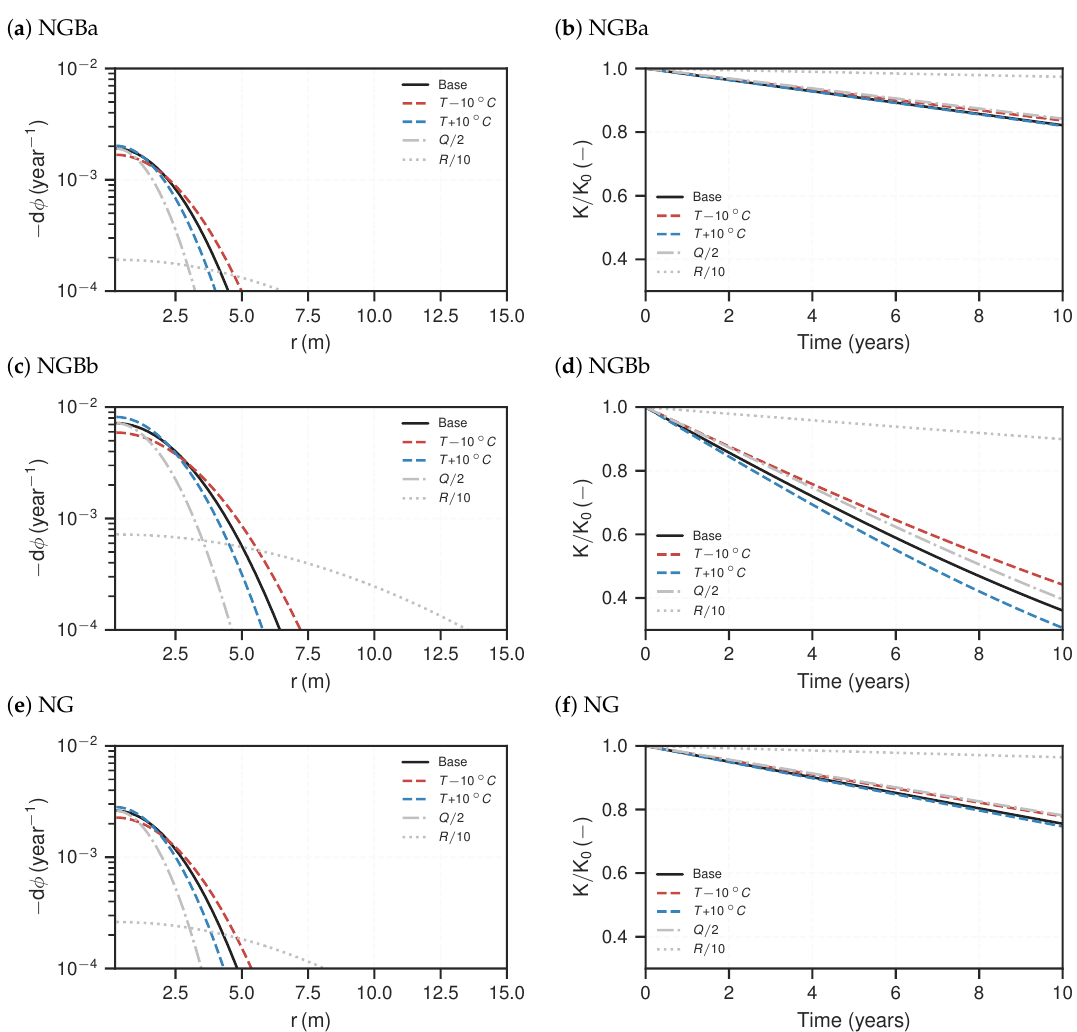
Figure 6. Reactive transport simulation results for the NGB cases. ( a , c , e ) Distribution of porosity change per year for steady-state. ( b , d , f ) Resulting relative, effective permeability loss (Equation (14)) based on the porosity–permeability relationship (Equation (13)) over the course of ten years. The lines represent respective